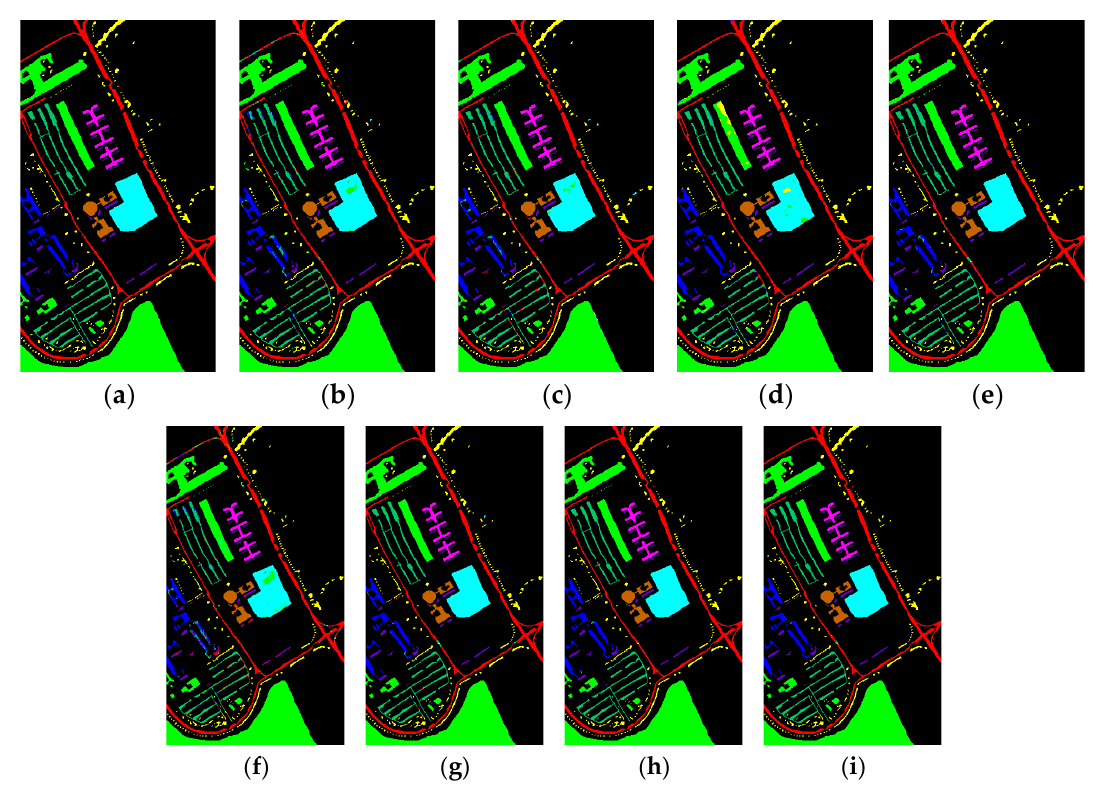
Figure 9. Classification maps generated by all of the competing methods on the University of Pavia data with 5% training samples; ( a ) is ground truth map, and ( b – i ) are the results of Baseline, 3DCNN, SSRN, HybridSN, ViT, 3D_Octave, OctaveVit, SATNet, respectively.